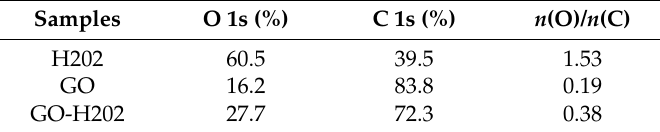
Figure 1. XPS ( a ), FT-IR spectrum ( b ) and TGA curves ( c ) of hyperbranched polyester H202, graphene oxide (GO), and GO-H202. Table 1. Fractions of C and O of H202, GO, and GO-H202.